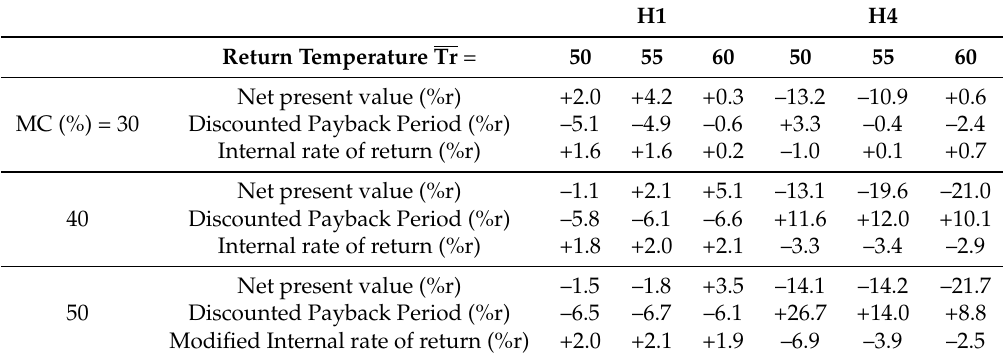
Table 7. Impact of the usual assumptions generally used on the viability of a project for the different scenario investigated in this